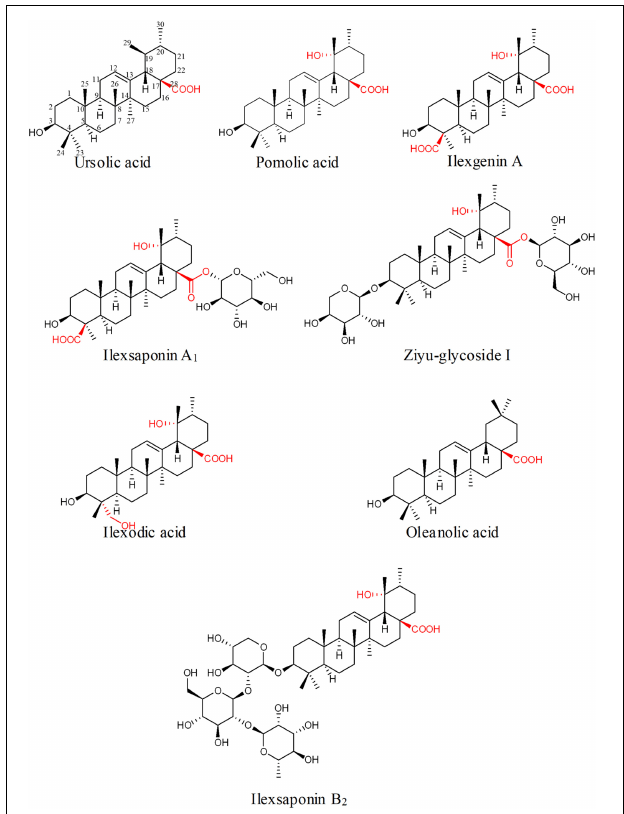
FIGURE 1 | Some simultaneous triterpenoids in Ilex asprella . These compounds were described in order to predict the structural characteristics of related compounds and expected related key enzymes. Substituents and substitution positions were indicated in